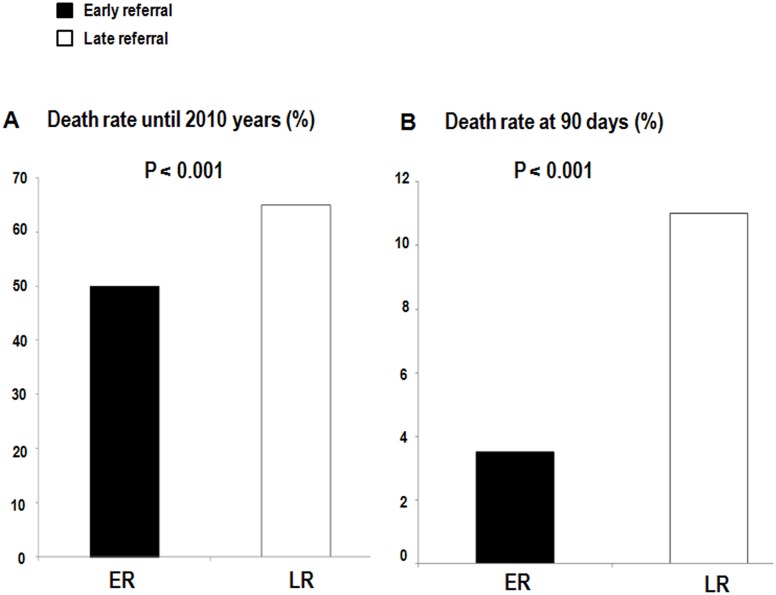
Death rate during total follow-up period (A) and at 90 days (B) according to referral timing.